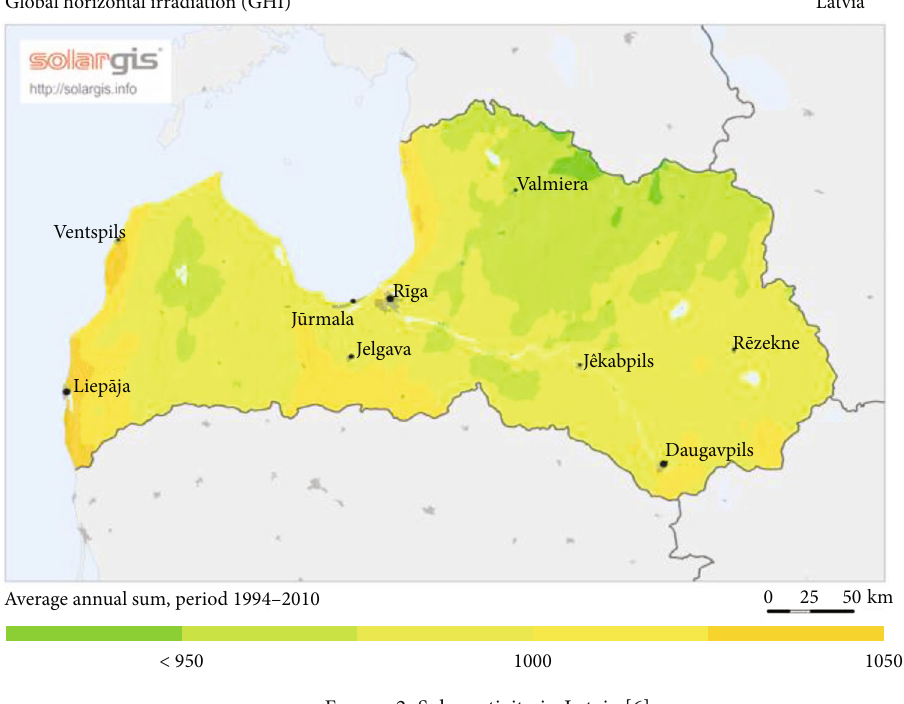
Figure 2: Solar activity in Latvia